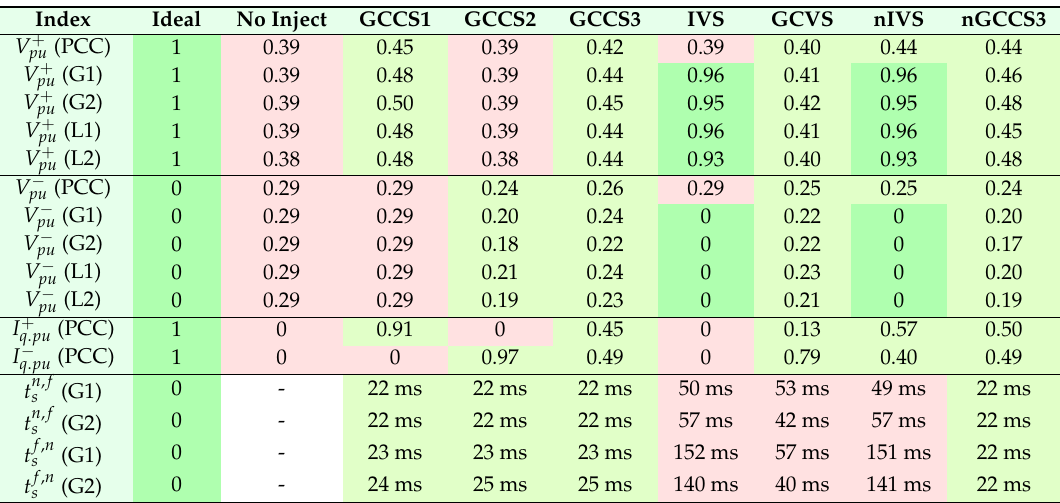
Table 5. Quality indexes measured for type II voltage sag.